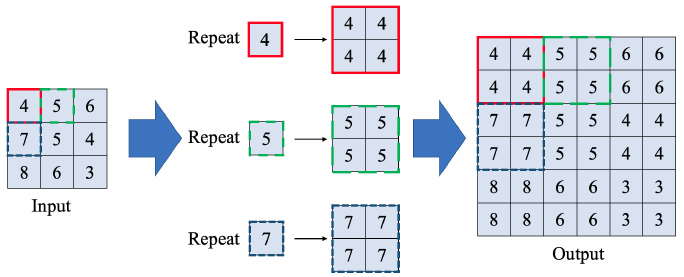
Figure 4. Example of Upsampling layer.